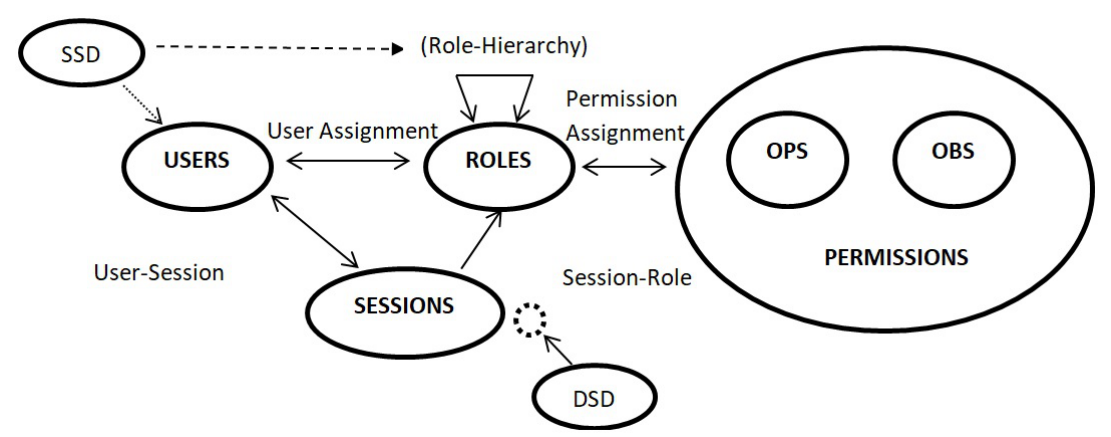
Figure 5. Role-Based Access Control (RBAC)